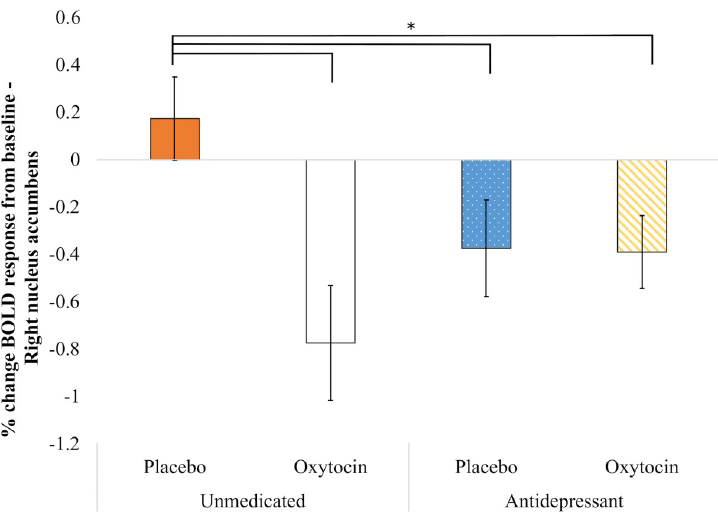
Fig 2. Activation of right nucleus accumbens to visual emotional stimuli, controlling for age, CES-D score, pre- trial urinary oxytocin, and activation to scrambled images. There were no significant contrasts between different stimuli types. � : p <